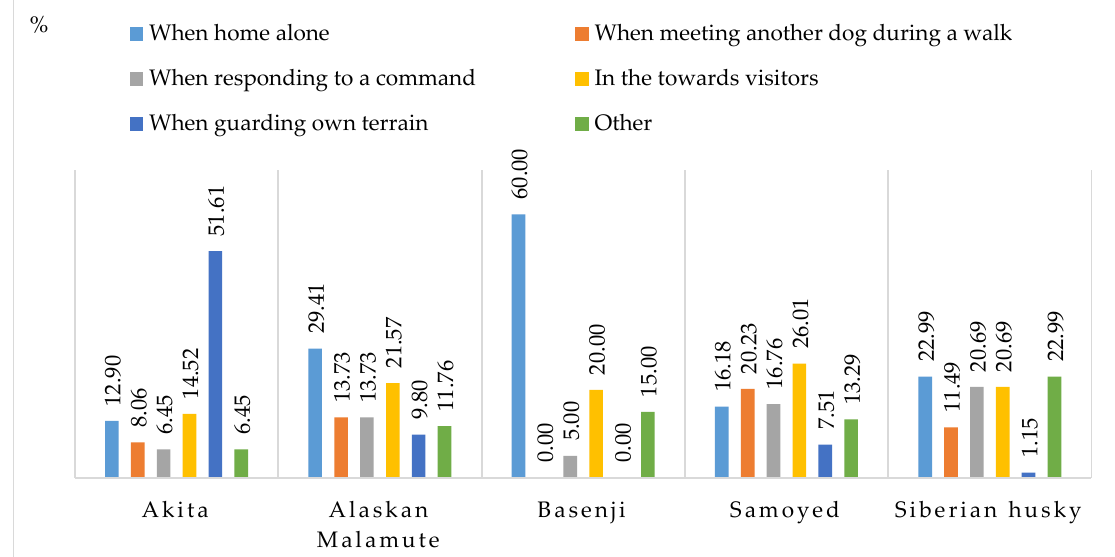
Figure 9. Situations that elicit excessive vocalization (%).